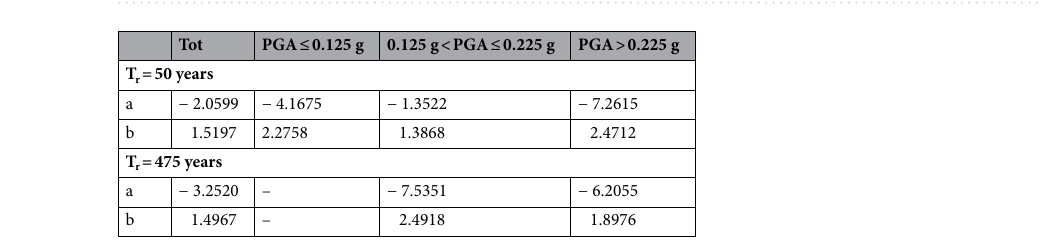
Table 2. Curve-fitting coefficients for the log of the exceedance area of the design actions as a function of magnitude.